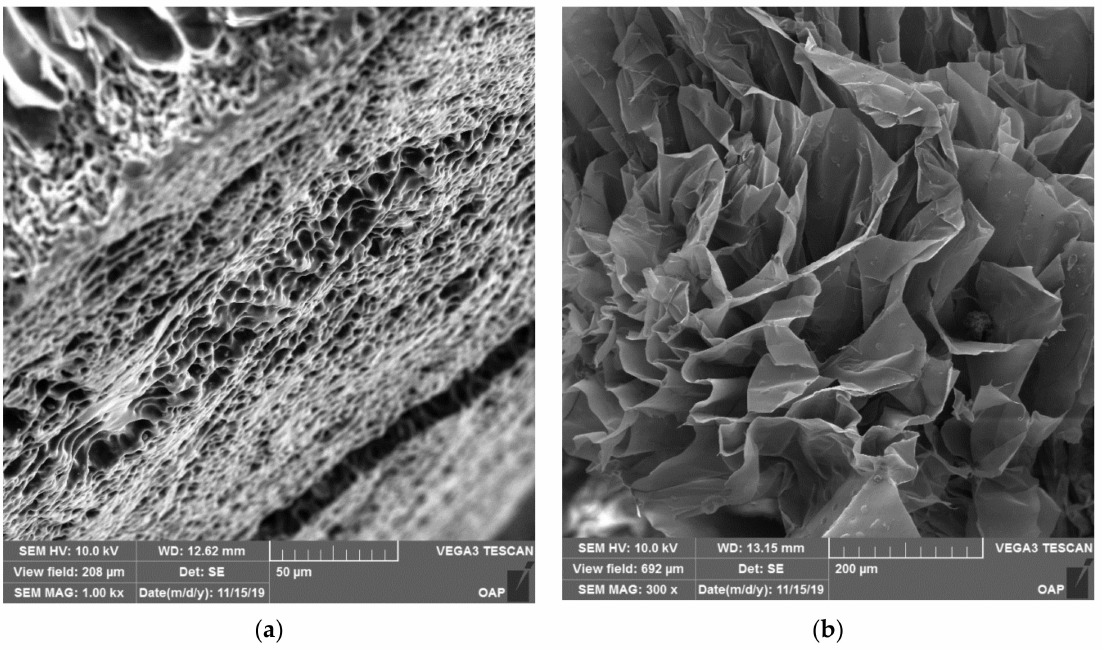
Figure 6. ( a ) SEM micrograph at magnification 1000 × of synthesized SWA after irradiation; ( b ) SEM micrograph at magnification 300 × of swollen SWA.